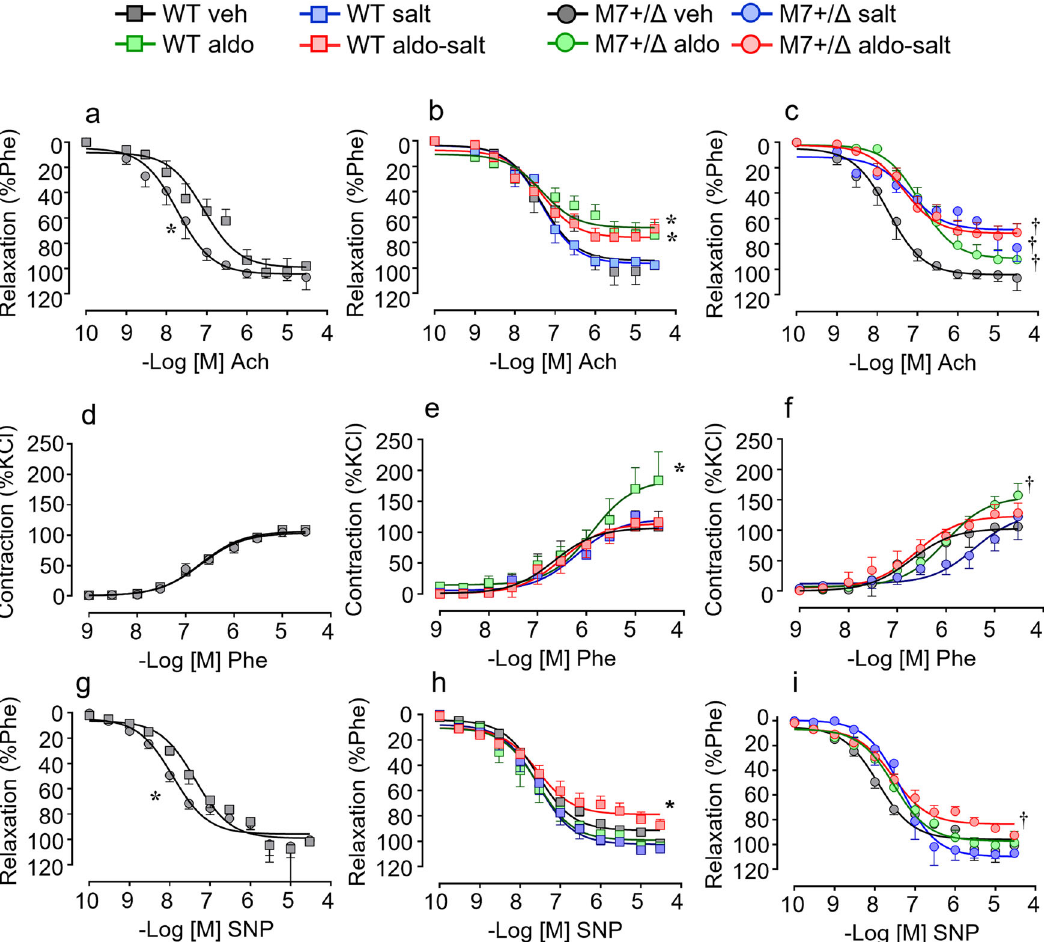
Fig. 2 Vascular function in WT and TRPM7 + / Δ kinase mice. Animals WT (squares) and TRPM7 + / Δ kinase (M7 + / Δ , circles) were treated with aldosterone (aldo, green), high salt (salt, blue) or aldosterone-salt (aldo-salt, red). Vascular function was assessed in mesenteric arteries by wire myograph. a – c vascular relaxation to acetylcholine (Ach); d – f vascular contractility to phenylephrine (Phe); g – i vascular relaxation to sodium nitroprusside (SNP). N numbers: WT (veh = 9 – 14; aldo = 7 – 10; salt = 7; aldo-salt = 11 – 13), M7 + / Δ (veh = 10 – 13; aldo = 8; salt = 7 – 8; aldo-salt = 12 – 15). Data are presented as mean ± SEM. Concentration-response data were analyzed by determining EC50 and maximal response (Emax) values from experimental data fi tted to a four-parameter logistic function against the null hypothesis (similar dataset). Null hypothesis was rejected when p < 0.05. * P < 0.05 vs WT veh; † p < 0.05 vs M7 + / Δ